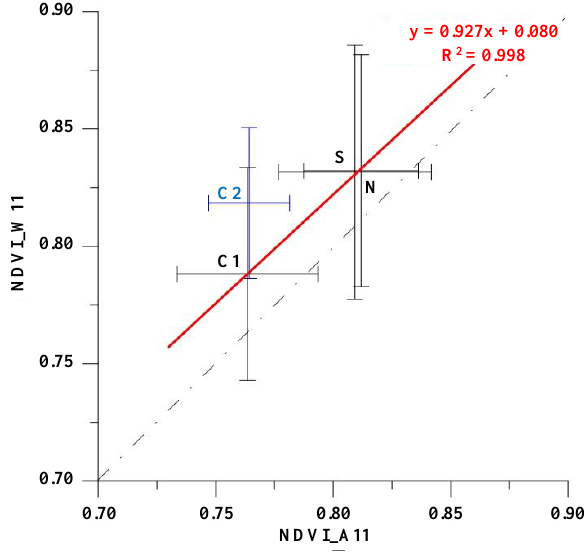
Figure 6. Relationship between the average NDVI_W11 AOI values and the average NDVI_A11 AOIs values